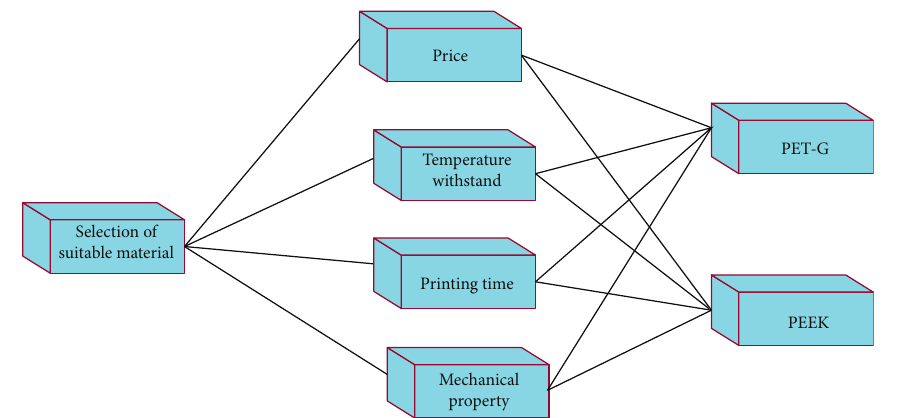
Figure 3: Methodology.